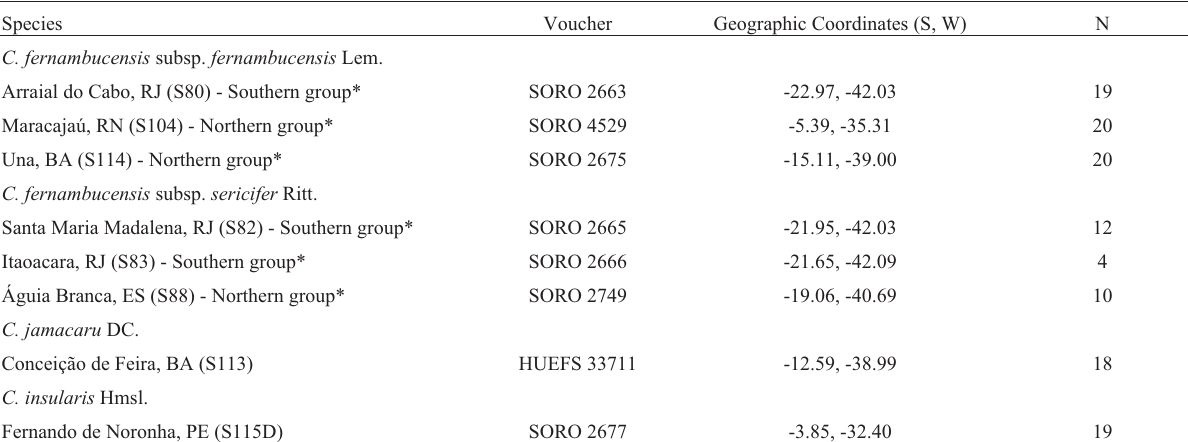
Table 1 - Geographical localities of the populations from three species of Cereus used in this work.